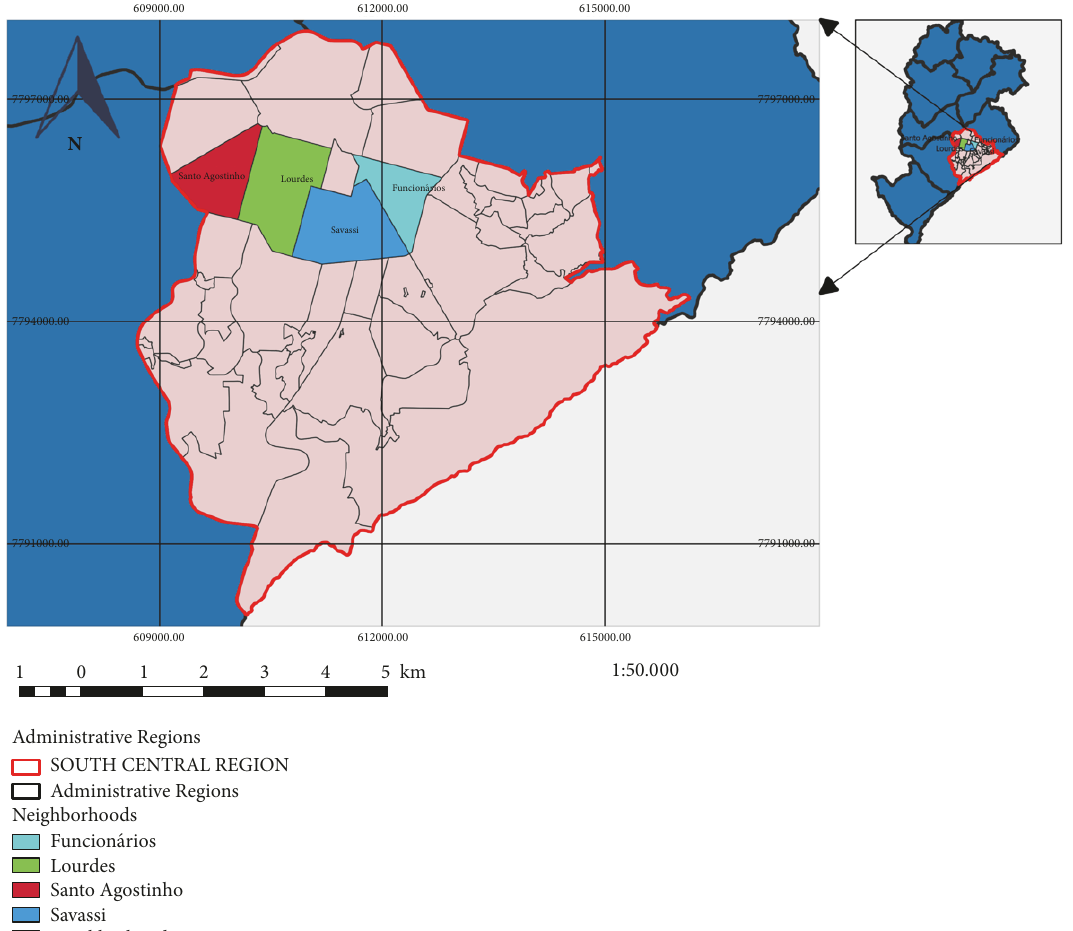
Figure 1: South-Central region of the municipality of Belo